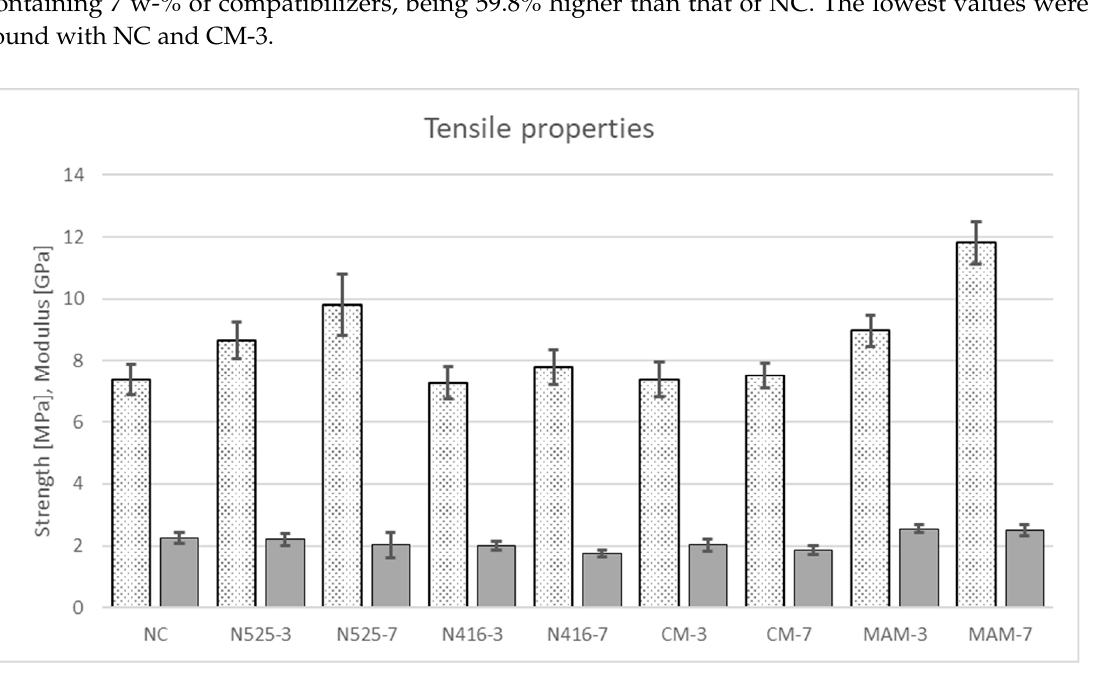
Table 1. Tensile properties relative to the reference. A difference not significant at 95% confidence level is marked with an asterisk (*).